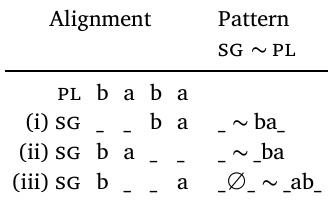
Table 5: Illustration of the alignment problem for two